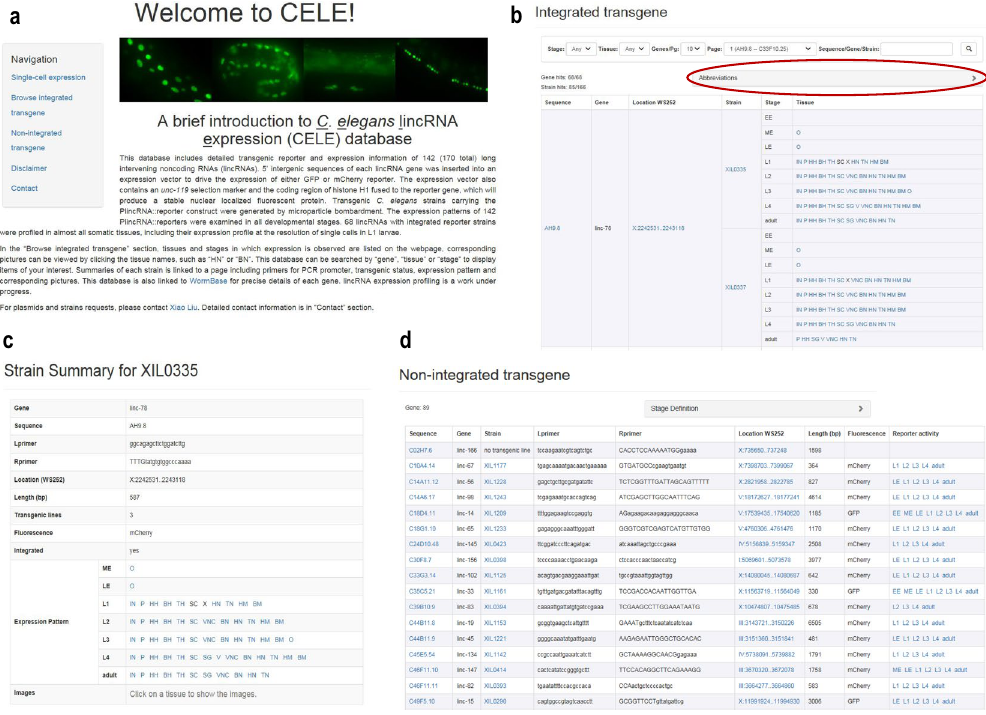
Figure 4. C. elegans lincRNA expression (CELE) database. ( a ) CELE database homepage. Hyperlinks at left are for users to navigate to the section of interest. ( b ) “Browse integrated transgene” section. The tissues and stages in which lincRNA reporter expression was observed are listed, and corresponding pictures can be viewed by clicking the tissue names. Definition of the abbreviation for each tissue and stage can be found at the top of the page (red circle). This database can be searched by “gene”, “tissue” or “stage”. ( c ) Strain summary page. ( d ) “Non- integrated transgene”